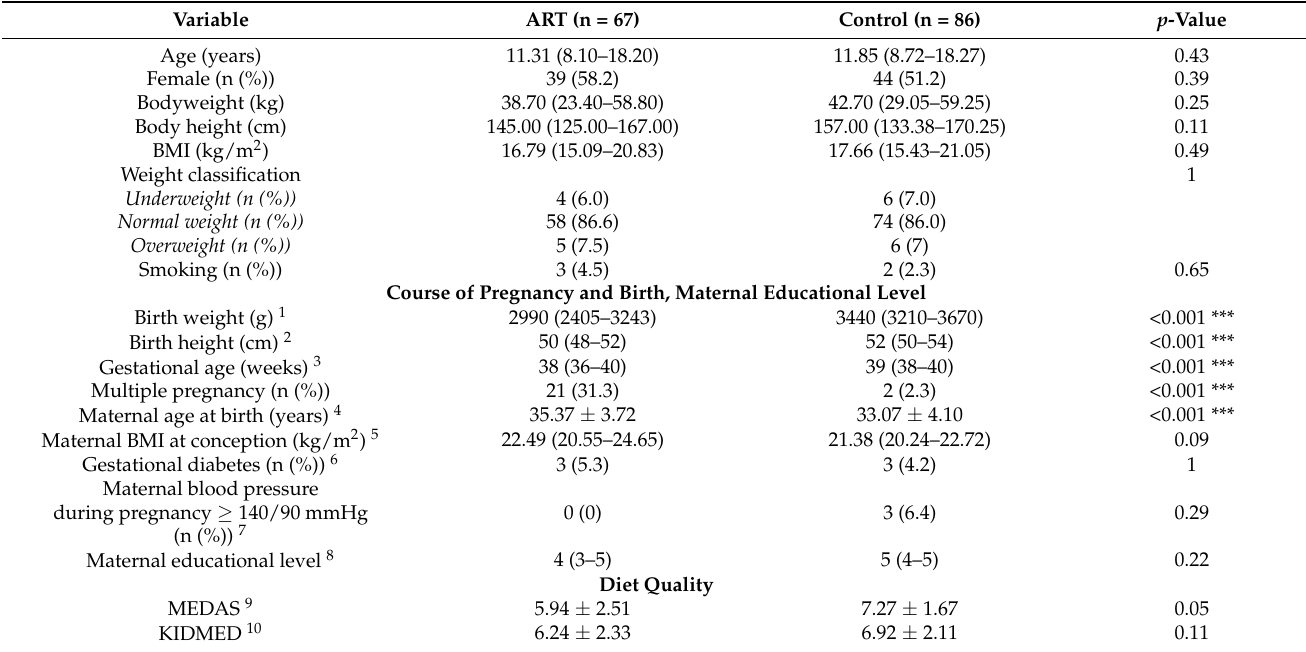
Table 1. Patients’ Characteristics in the ART and Control Group.